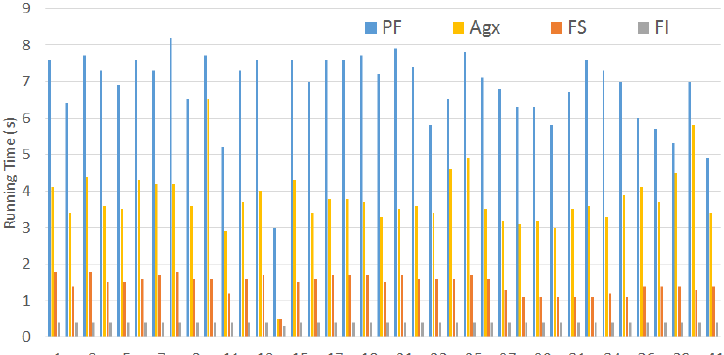
Figure 9. Total runtime of different methods on the TCAS programs.